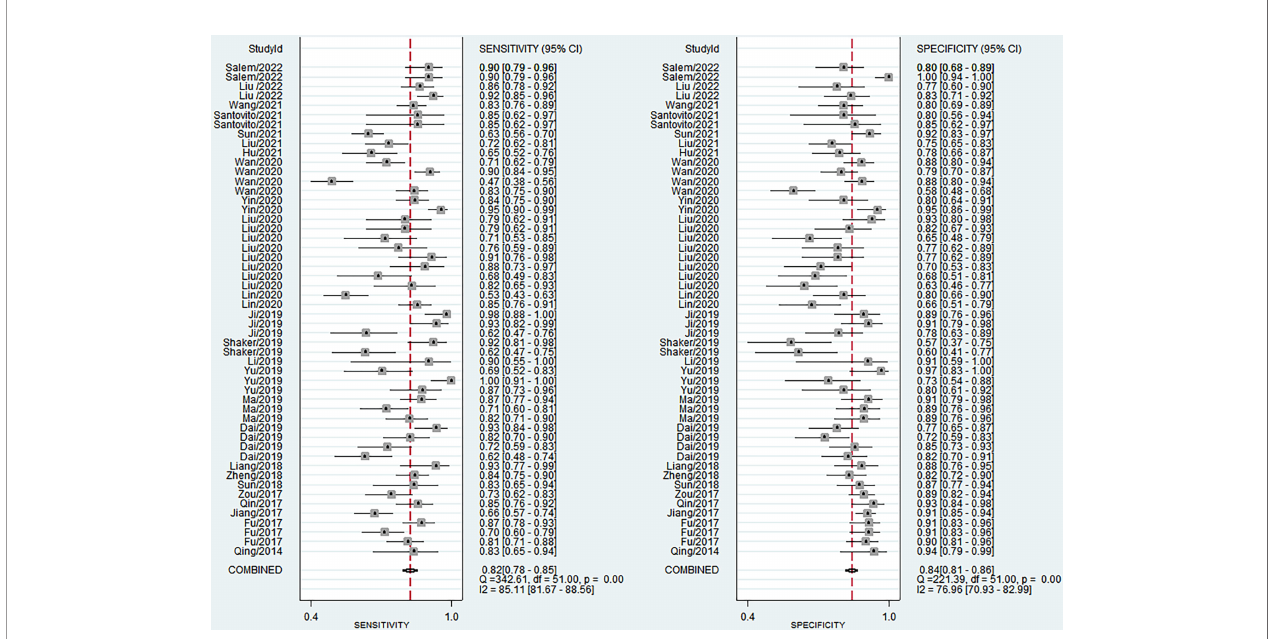
FIGURE 3 | Forest plots of studies examining microRNAs used in the diagnosis of diabetic